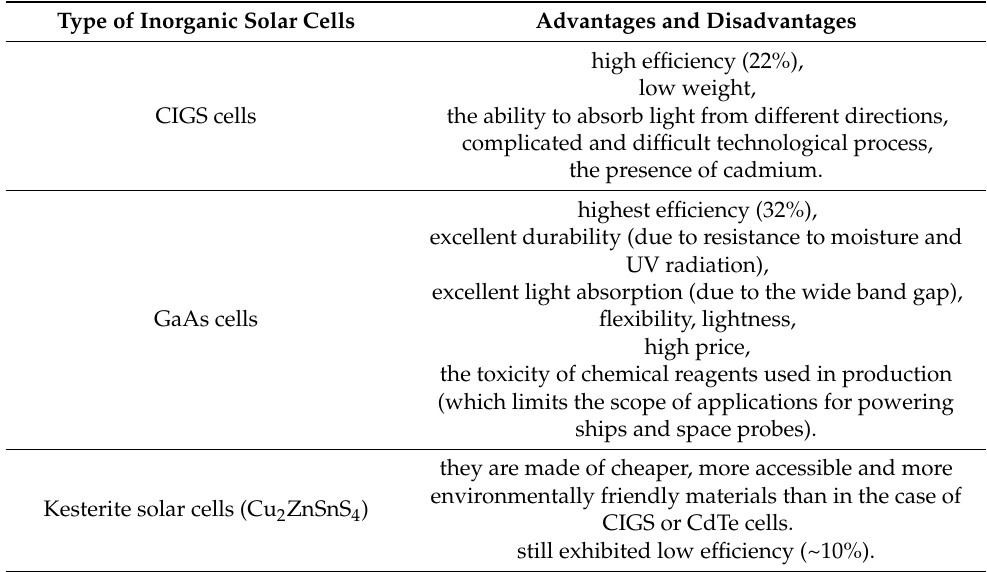
Table 3. Cont. Type of Inorganic Solar